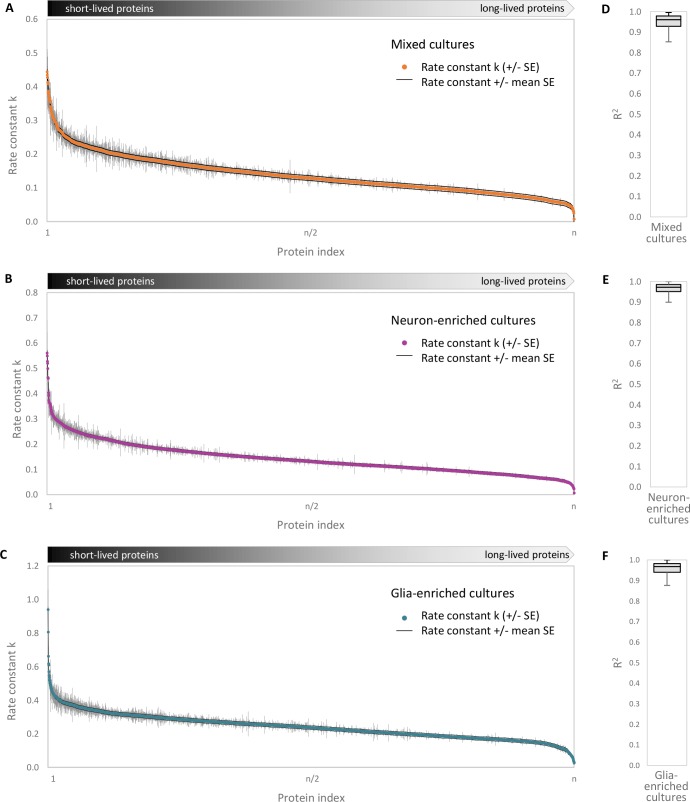
Accuracy of turnover estimation.Protein half-lives were determined based on a linear fit of the fraction of pre-existing proteins over time. Rate constants k (negative value of the slope of the fit) and the SE (standard error of the slope) are shown for each protein group. (A) Mixed cultures, (B) neuron-enriched cultures and (C) glia-enriched cultures. The mean SE of the slopes for each culture type is shown as a black line. Coefficients of determination (R2) of the linear fits for (D) mixed cultures, (E) neuron-enriched cultures and (F) glia-enriched cultures. The boxes represent the upper quartile (Q3), median and lower quartile (Q1) and the antennas represent the upper limit (maximum) and the lower limit (Q1-1.5*IQR).